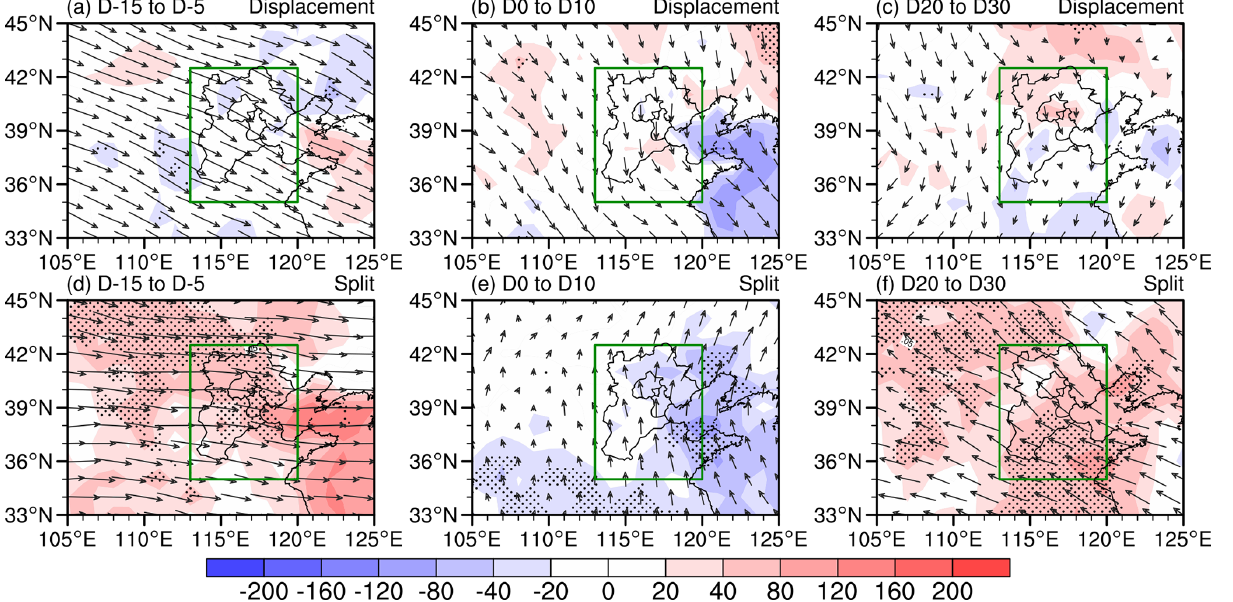
Figure 5. Composite planetary boundary layer height (BLH; shadings) and 850hPa wind (vector) anomalies in the BTH region during three periods of the SSW for vortex displacement events (a–c) and vortex split events (d–f) . (a, d) Day − 15 to day − 5 in the pre-SSW period. (b, e) Day 0 to day 10 in the SSW onset period and afterwards. (c, f) Day 20 to day 30 in the SSW decaying period. The dotted regions mark the composite BLH anomalies at the 90% confidence level based on the two-sided Student’s t test. The green box marks the focused BTH